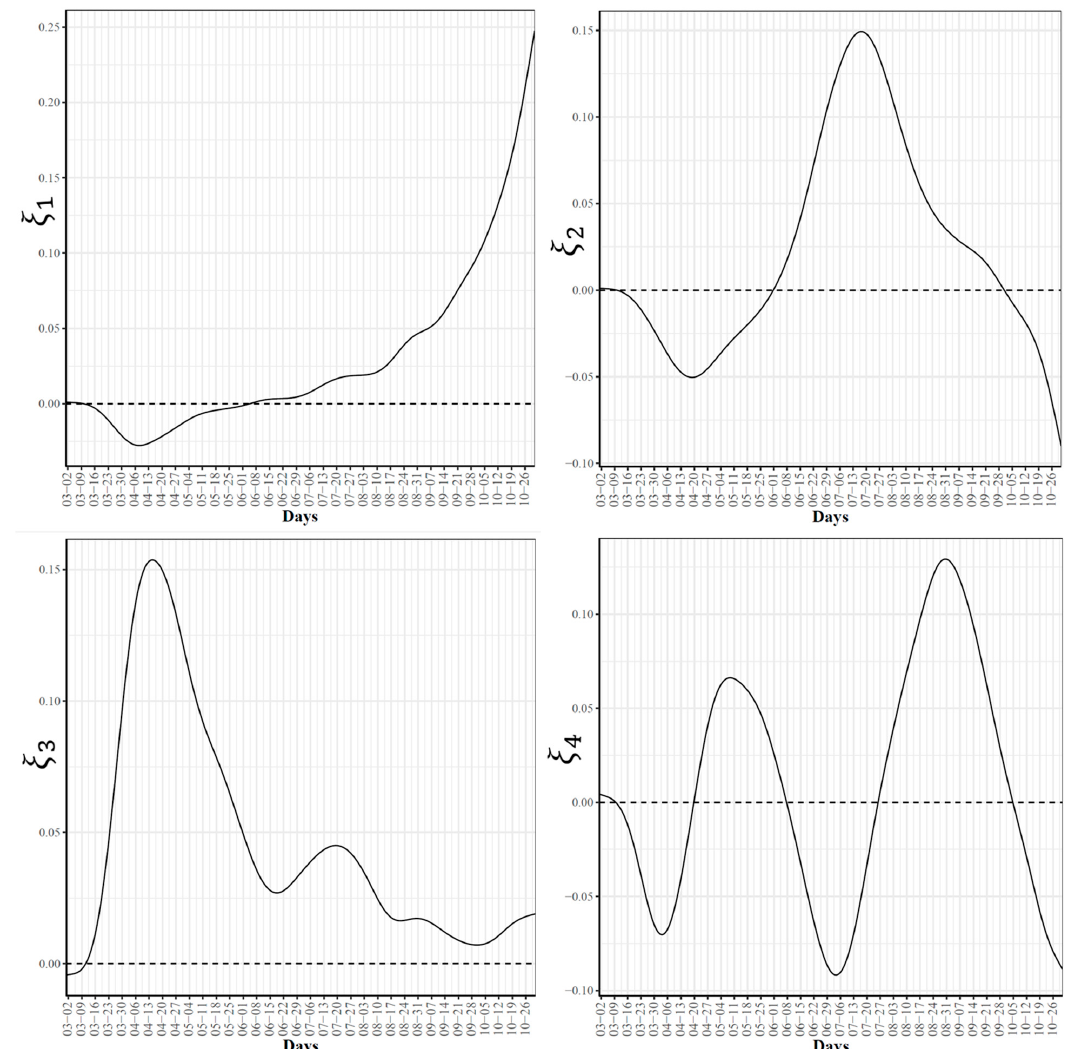
Figure 3. First four eigenfunctions of COVID-19 confirmed case trajectories.